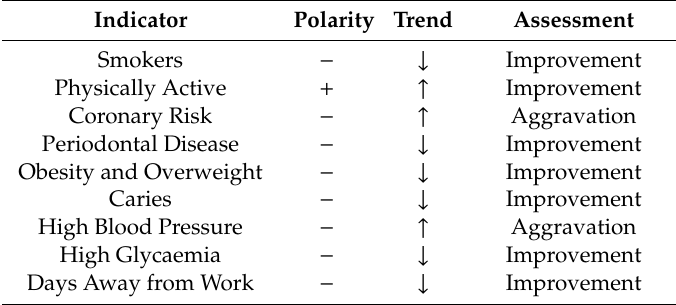
Table 6. Test group indicators’ assessment after health intervention (2006–2015). Indicator Polarity Trend Assessment Smokers − ↓ Improvement Physically Active + ↑ Improvement Coronary Risk − ↑ Aggravation Periodontal Disease − ↓ Improvement Obesity and Overweight − ↓ Improvement Caries − ↓ Improvement High Blood Pressure − ↑ Aggravation High Glycaemia − ↓ Improvement Days Away from Work − ↓